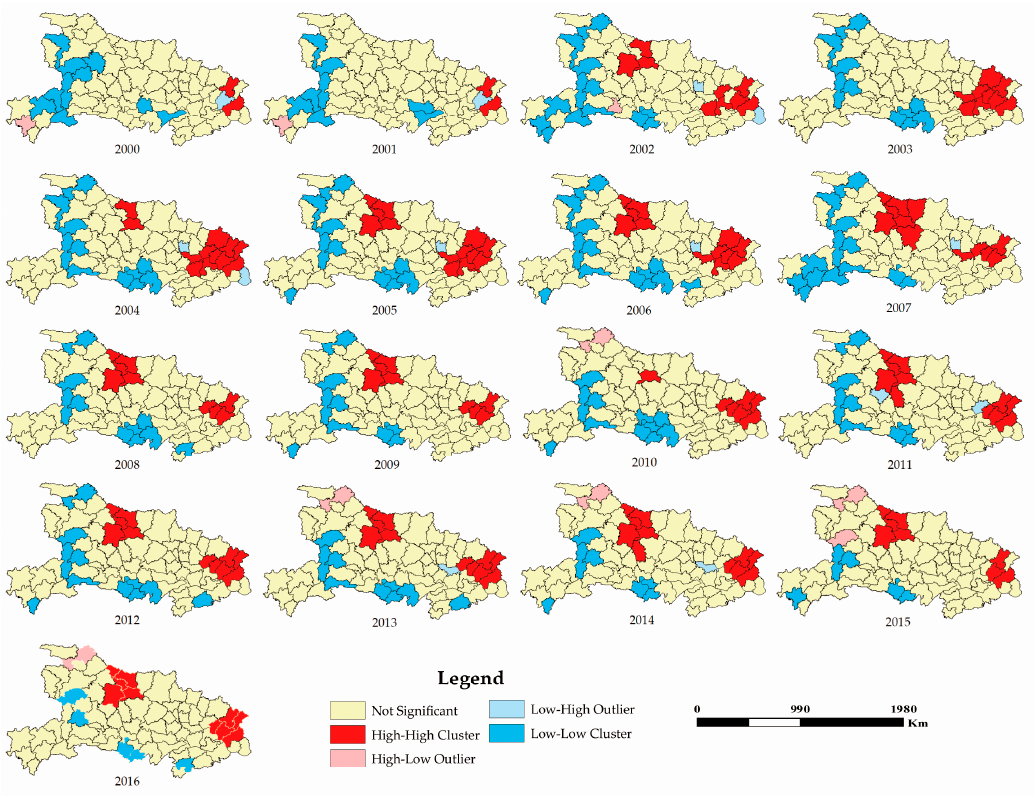
Figure 2. LISA figures on agricultural land use intensity in Hubei Province from 2000 to 2016.